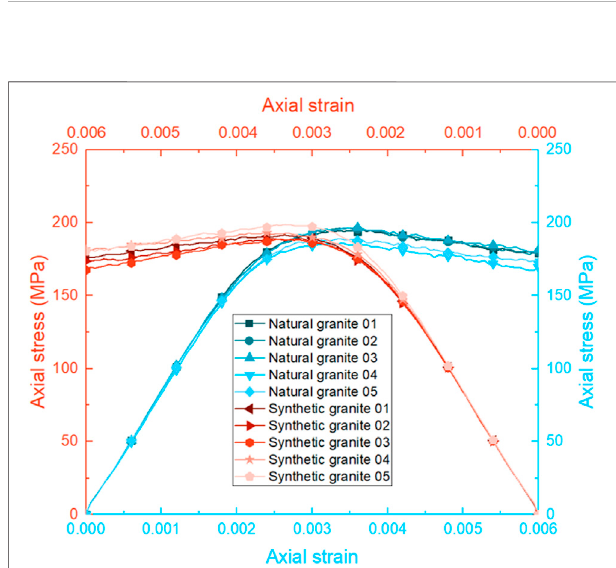
FIGURE 6 | The stress-strain curves of natural granite and equal-size synthetic granite.